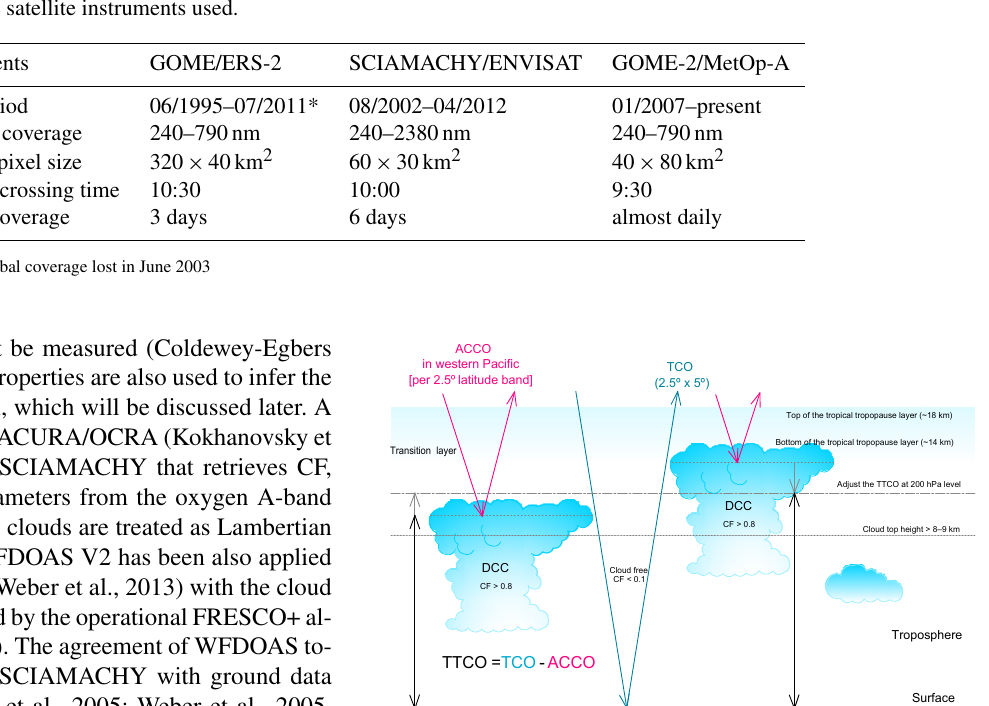
Table 1. Characteristics of the satellite instruments used.